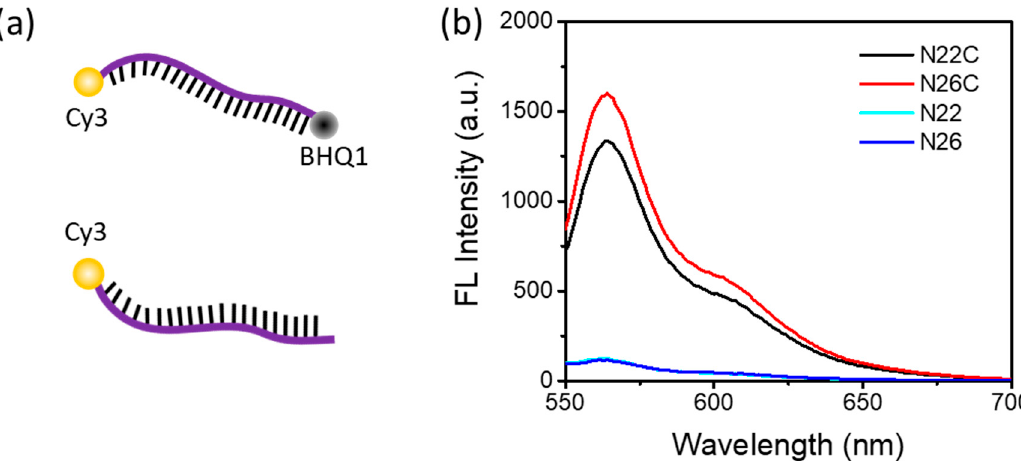
Figure 1. DNA probes and their fluorescence emission spectra ( a ) DNA probe dual labeled with a fluorophore and a quencher, or single labeled with a fluorophore. ( b ) Fluorescence emission of Cy3-labeled fluorescence probes in the presence or absence of the quencher BHQ1. The concentration of each probe used in these experiments was 1 μ M.